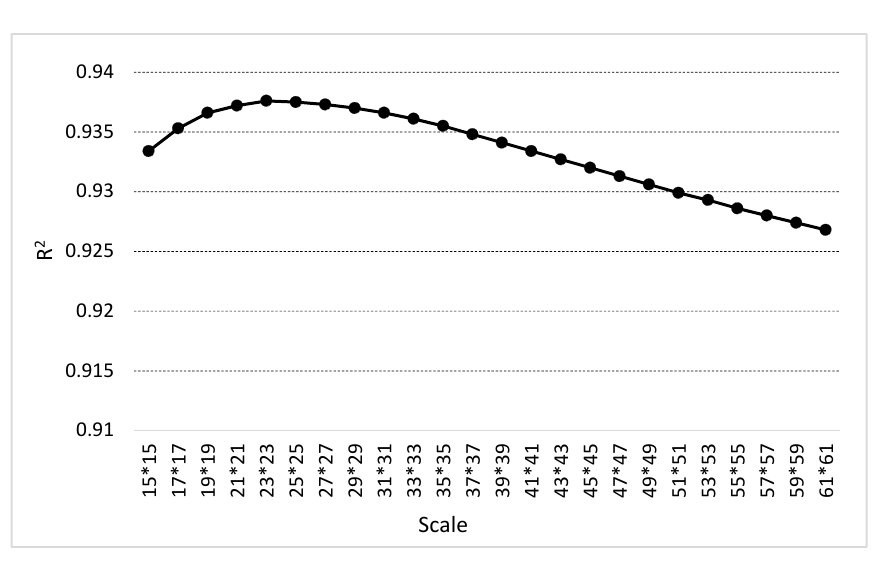
Figure 4. 𝑅 (cid:2870) variation with aggregation scale. Figure 4. R 2 variation with aggregation scale.